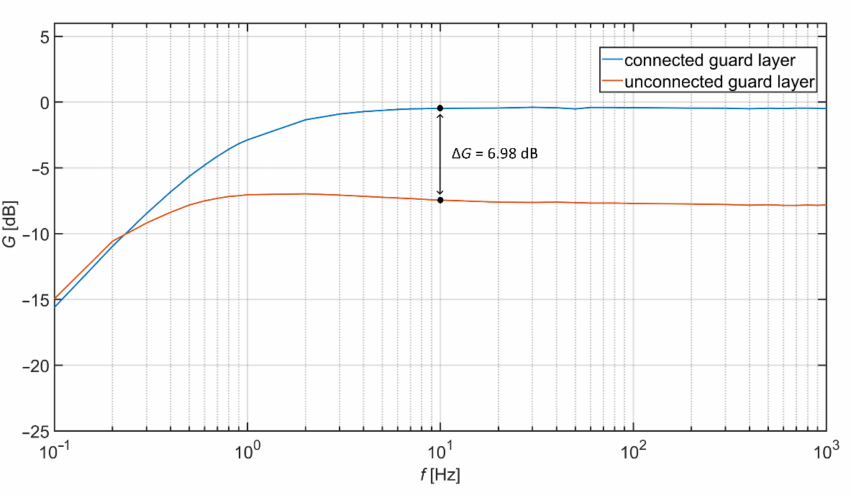
Figure 4. Measured transfer characteristics.